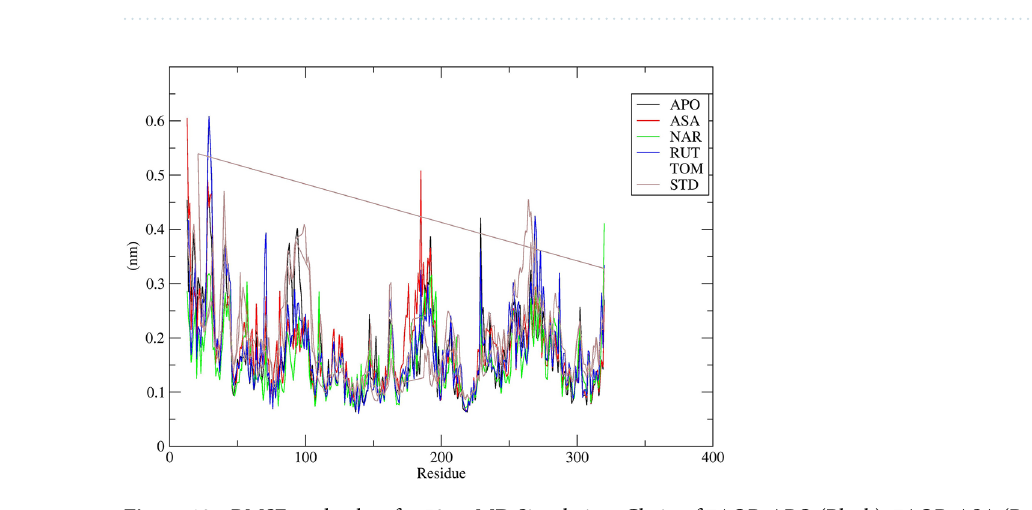
Figure 11. RMSD study plot for 50 ns MD Simulation of 7AQB-APO (Black), 7AQB-ASA (Red), 7AQB-NAR (Green), 7AQB-RUT (Blue), 7AQB-TOM (Yellow) and 7AQB-STD (Brown).